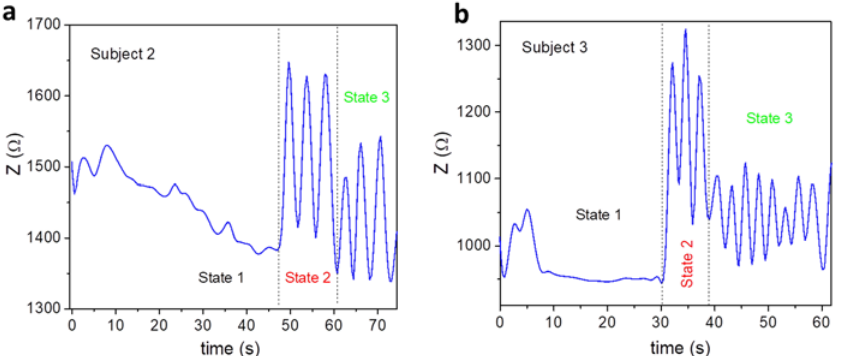
Figure 5. Breathing patterns of subjects aged ( a ) 36 and ( b ) 42 years old at three different states; State 1: breath holding, State 2: breath releasing, and State 3: normal breathing.